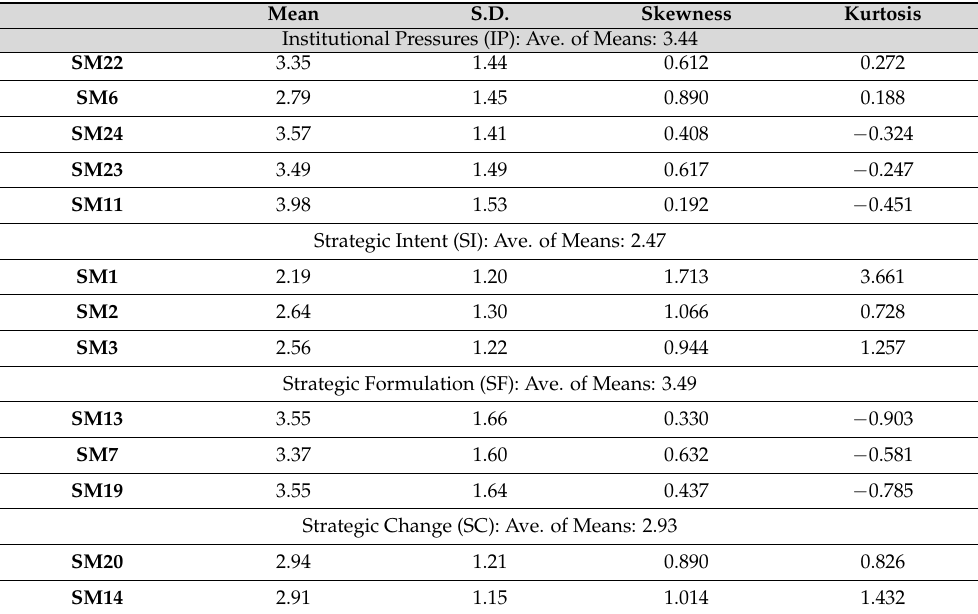
Table 5. Descriptive statistics of final